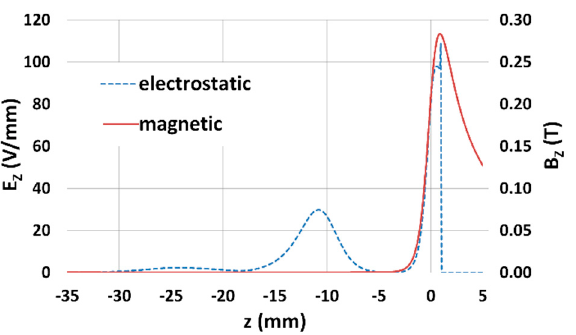
Figure 1. The arrangement used for simulation; through-the-lens detector and auxiliary electrodes inside the objective lens are shown schematically.